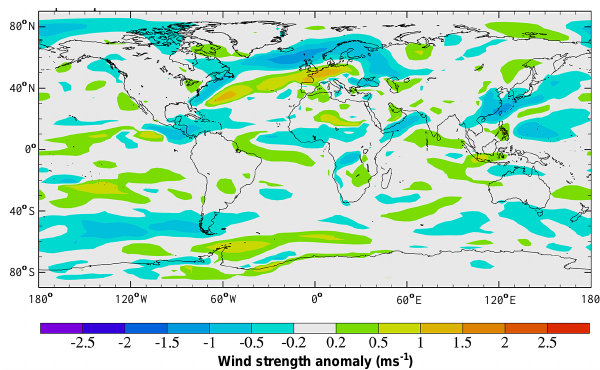
Figure 10. JJA 850hPa wind strength anomalies (ms − 1 ) for KK10 minus control for the late pre-industrial period (1850).